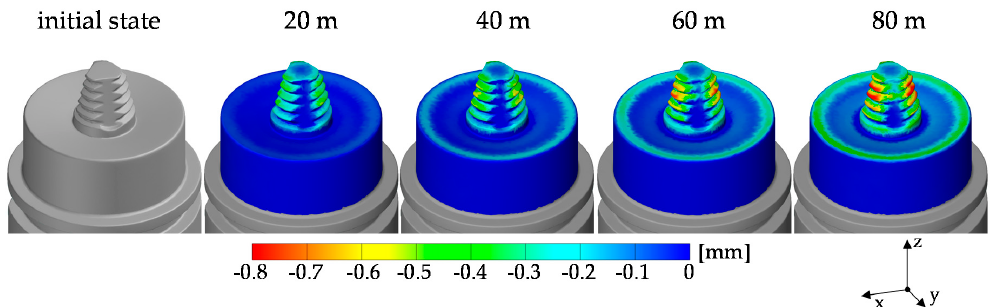
Figure 12. 3D surface measurement of the tools as a function of the weld seam